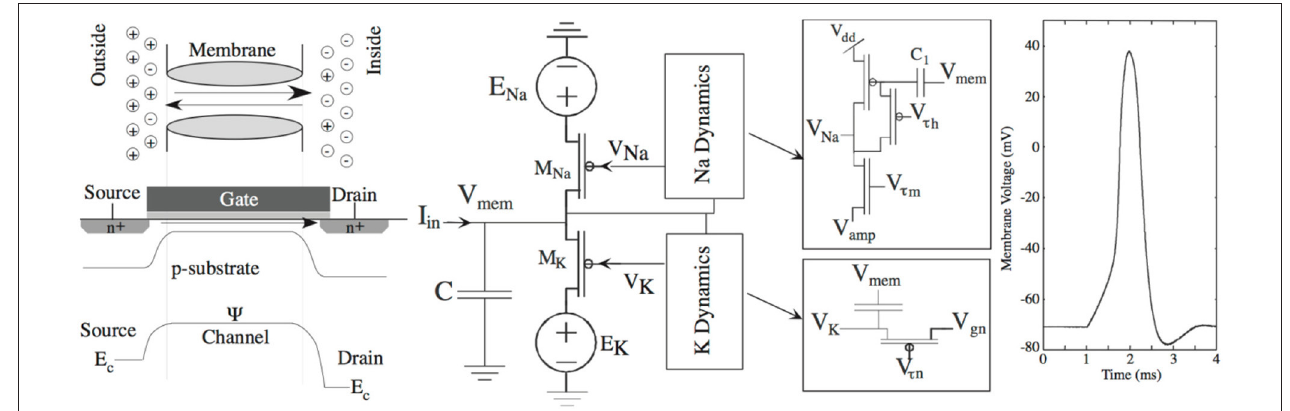
FIGURE 24 | An overview of MOSFET channel modeling of biological channels. This approach is possible given the similar (although not identical) physics between MOSFET and biological channels, both modulated by a gating potential. The physical structure of a biological channel consists of an insulating phosphor-lipid bilayer and a protein that stretches across the barrier. The protein is the channel in this case. The physical structure of a MOSFET consists of polysilicon, silicon dioxide, and doped n-type silicon. A channel is formed between the source and the drain. The band diagram of silicon has a similar shape to the classical model of membrane permeability. This approach yields an updated model for modeling biological channels that also empowers dense MOSFET implementation of these approaches. The primary design constraint is modeling the gating function with other transistor devices; such an approach is shown to model the classic Hodgkin–Huxley squid axon data, resulting in a close model to the event, as well as voltage clamp experiments.